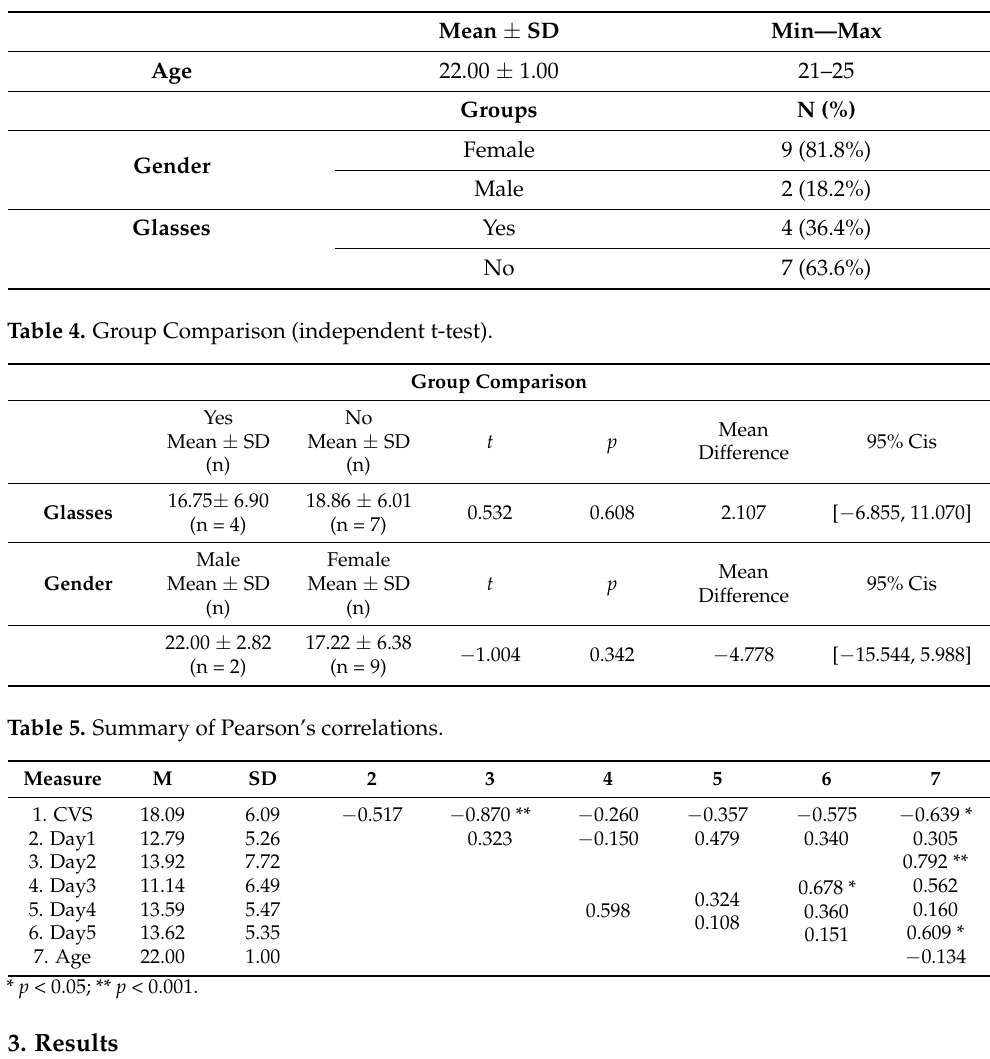
Table 3. Sample characteristics (n = 11).